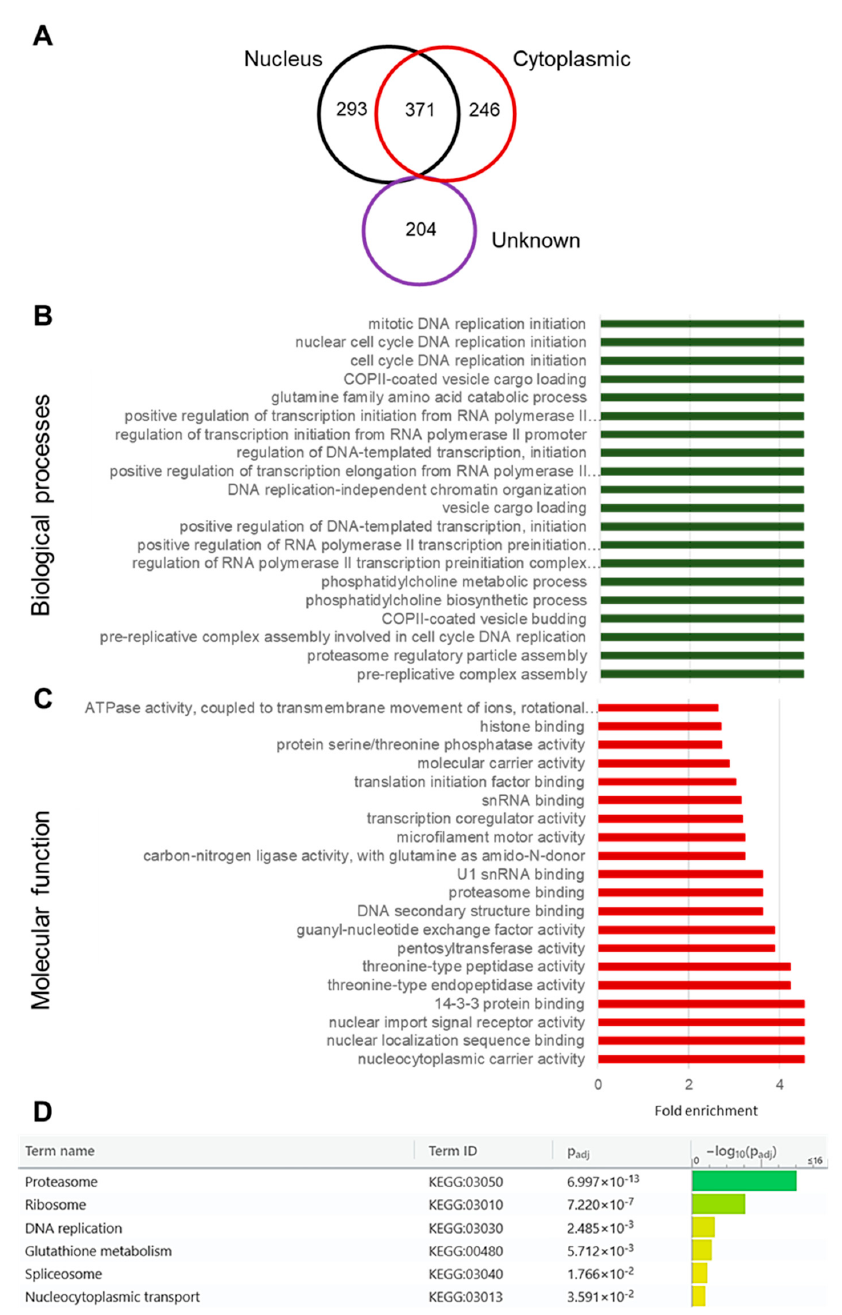
Figure 5. Functional prediction analysis of putative interaction partners of Pf SAMS. A total of 1114 identified potential interactors of Pf SAMS were matched to the PlasmoDB database entries for their cellular localization, biological processes, and molecular function based on GO term enrichment analyses of both computed and curated data at a p -value of 0.01. ( A ) Venn diagram showing the predicted nuclear and cytoplasmic localization of the identified interactors, including proteins of unknown localization. The GO categories “Nucleus” (GO:0005634) and “Cytoplasm” (GO:0005737) were considered. ( B , C ) Interactors of the 20 highest scoring biological processes ( B ) and 20 highest scoring molecular functions ( C ) as predicted by GO enrichment analysis, sorted by fold enrichment. ( D ) KEGG analysis of Pf SAMS interactors. Transcriptional regulation and chromatin remodeling factors were identified with at least 20 interacting proteins (Figures 6 and S6). Among the key interactors, the putative protein